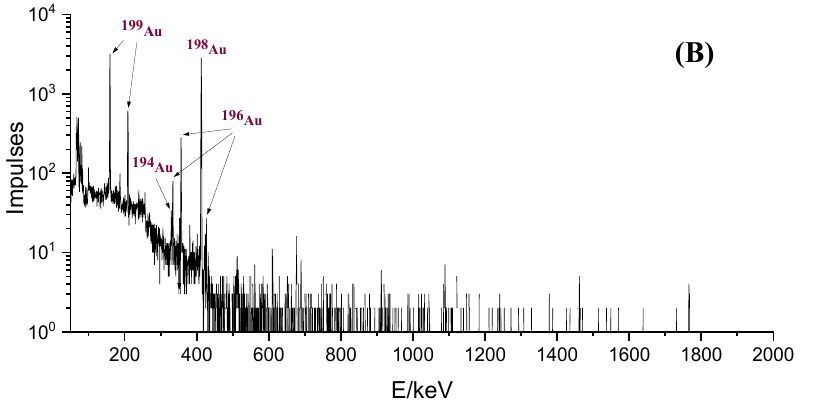
Figure 3. The spectrum of the irradiated target one day after the end of irradiation ( A ), and the spectrum of Au fractions separated from the column ( B ). The most intense peaks of the identified isotopes are marked.